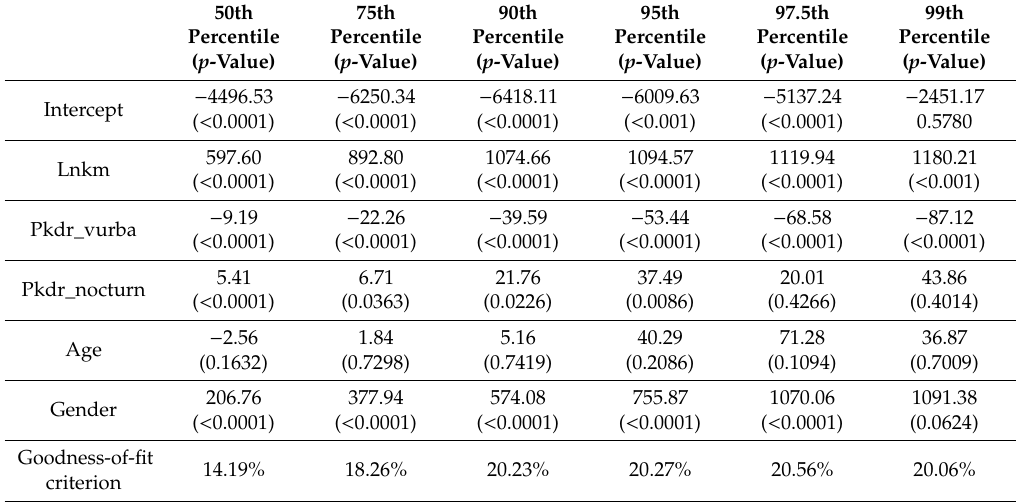
Table 4. Parameter estimates of the quantile regression model for di ff erent